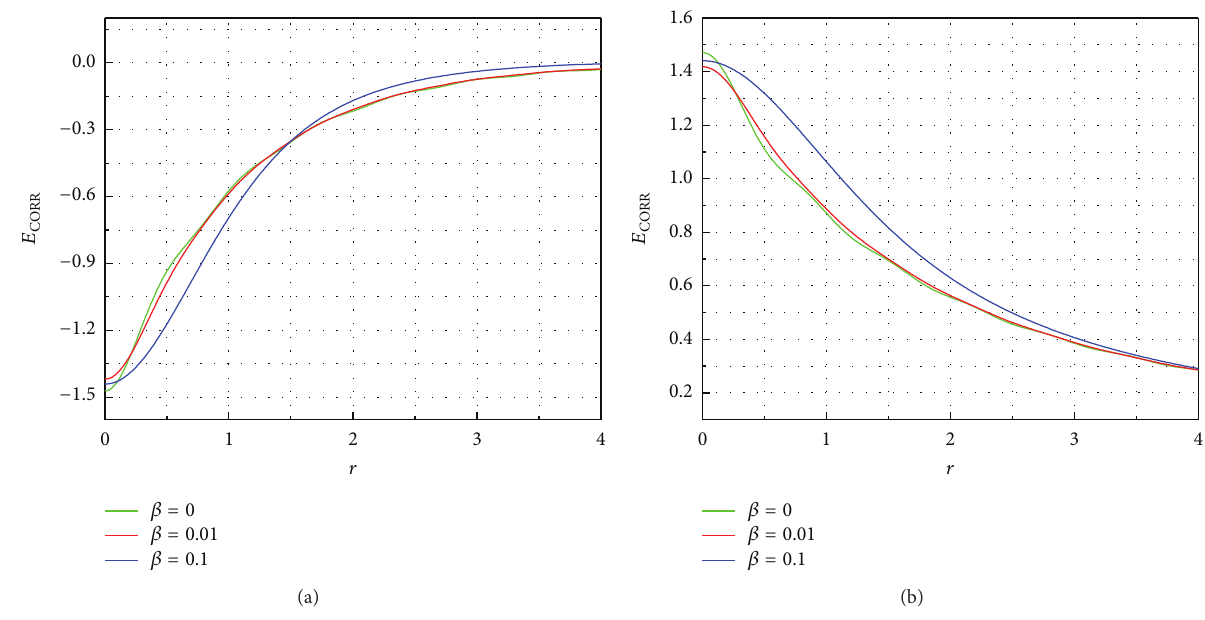
Figure 4: Real part (a) and norm (b) of 𝐸